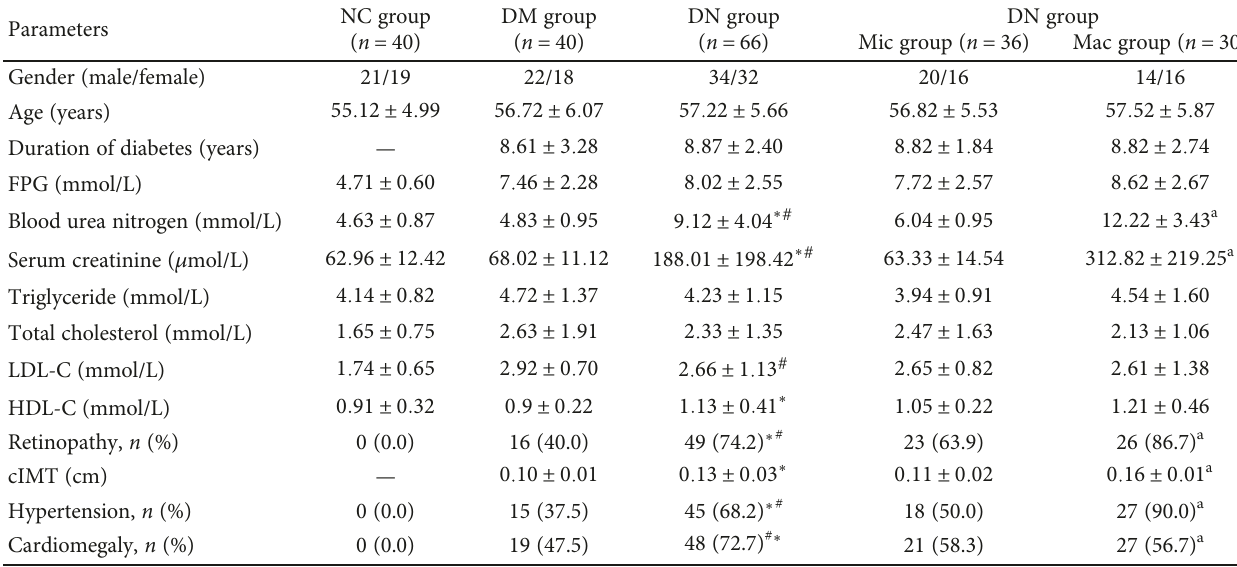
Table 1: Characteristics of